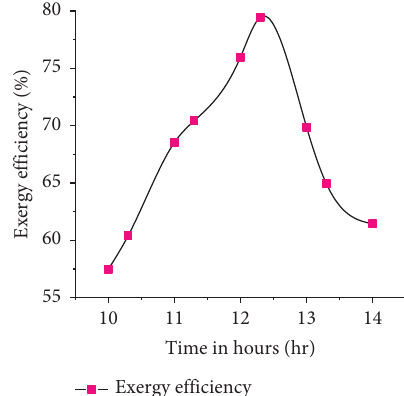
Figure 5: Variation of exergy efciency with the dehydrating period.